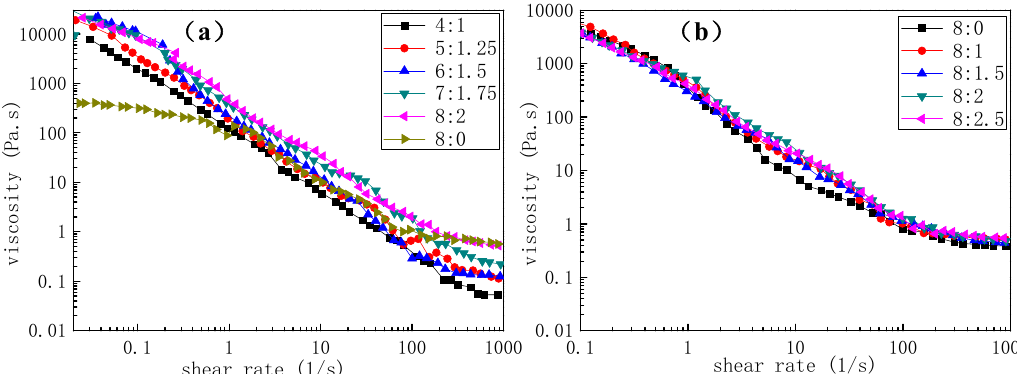
Figure 2. Viscosity of the solutions: ( a ) solutions with different concentrations; and ( b ) solutions of 8% PLA containing various ratios of chitosan.